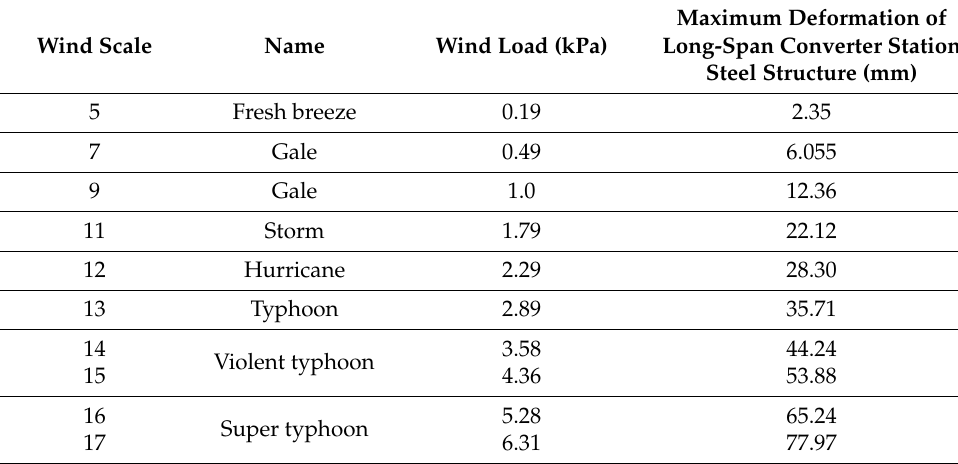
Table 4. The maximum deformation of the long-span converter station steel structure in the process of hoisting, considering 17 levels of wind